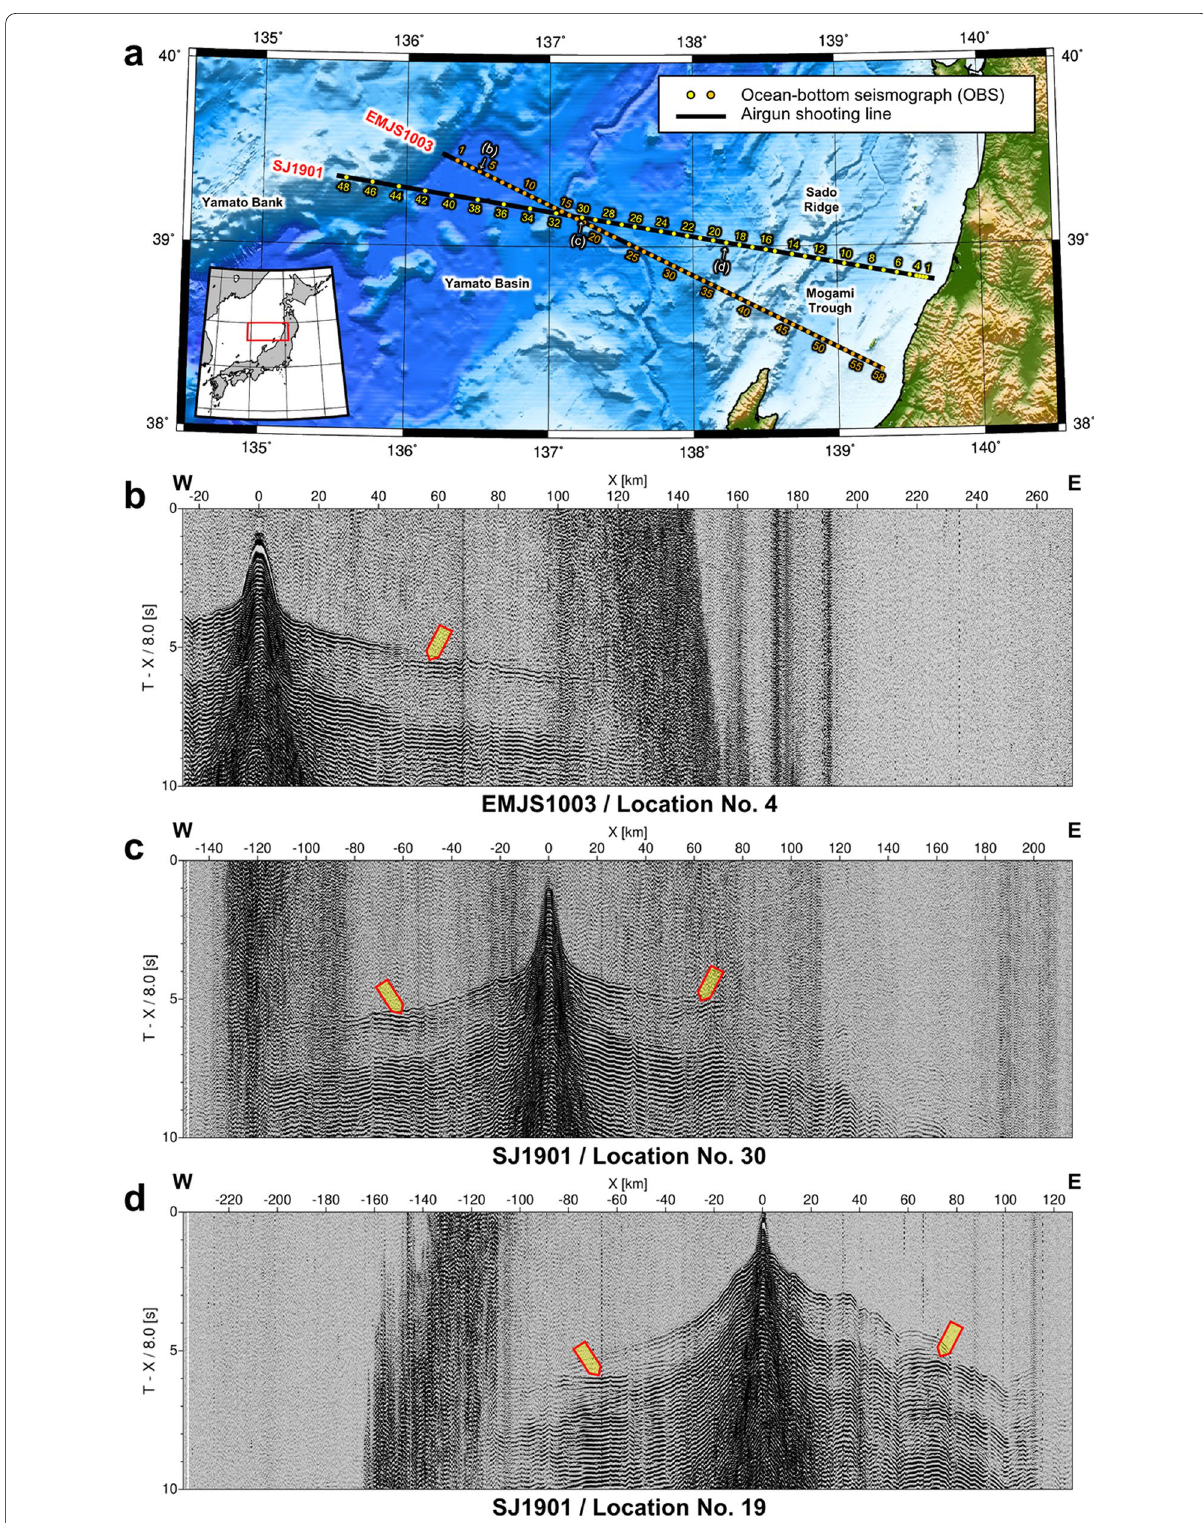
Fig. 1 Map of survey lines and examples of airgun-OBS survey data. a Two survey lines, EMJS1003 and SJ1901, are located off the western coast of Niigata and Yamagata, Japan. OBS records at b No. 4 along line EMJS1003, c No. 30 and d No. 19 along line SJ1901. Clear reflections from the Moho are visible in the recorded sections, which are indicated by yellow